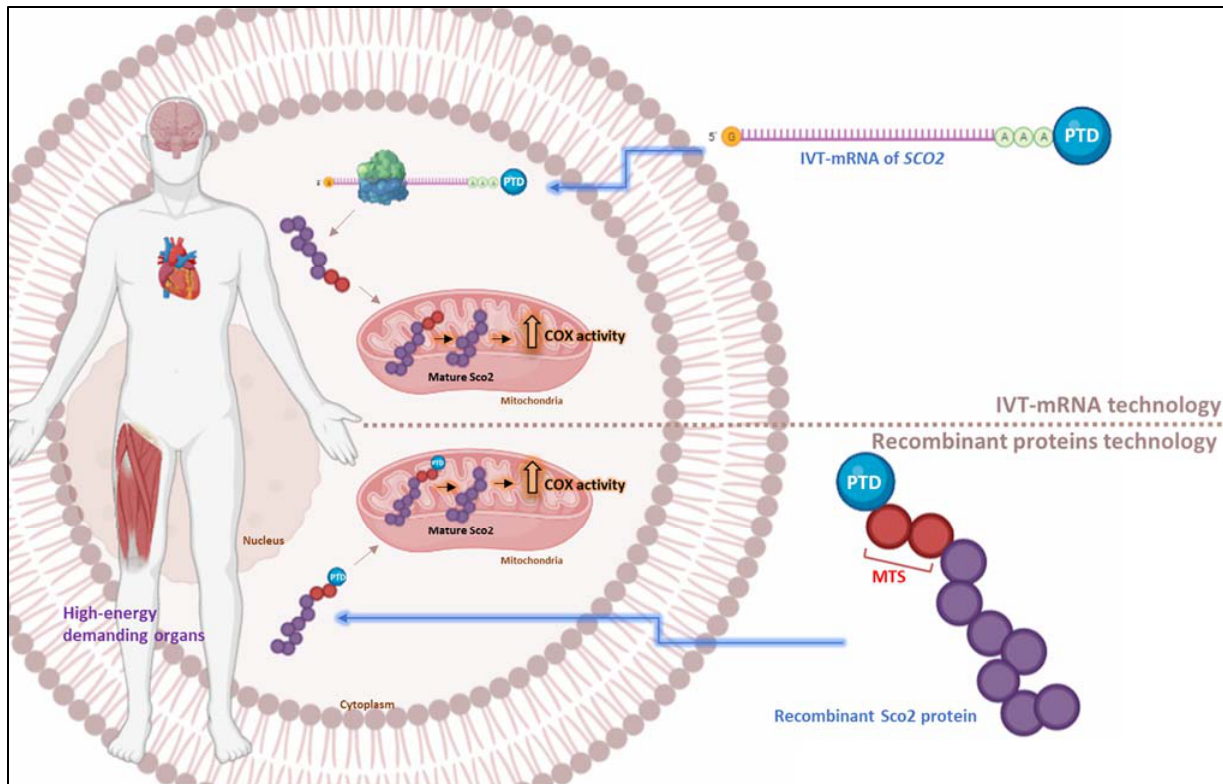
Figure 1. The exploitation of PTD technology for the efficient expression of the Sco2 protein into cells derived from a SCO2 /COX-deficient patient. PTDs can mediate the efficient intracellular transduction of recombinant full-length Sco2 protein or the transduction of the IVT-mRNA of SCO2 , which will be translated to Sco2 protein into cells’ cytoplasm. Notably, by both approaches, recombinant Sco2 will be delivered inside the mitochondria through its mitochondrial targeting signal peptide and be processed by mitochondrial processing peptidase to give the mature Sco2, thus facilitating the recovery of COX activity.